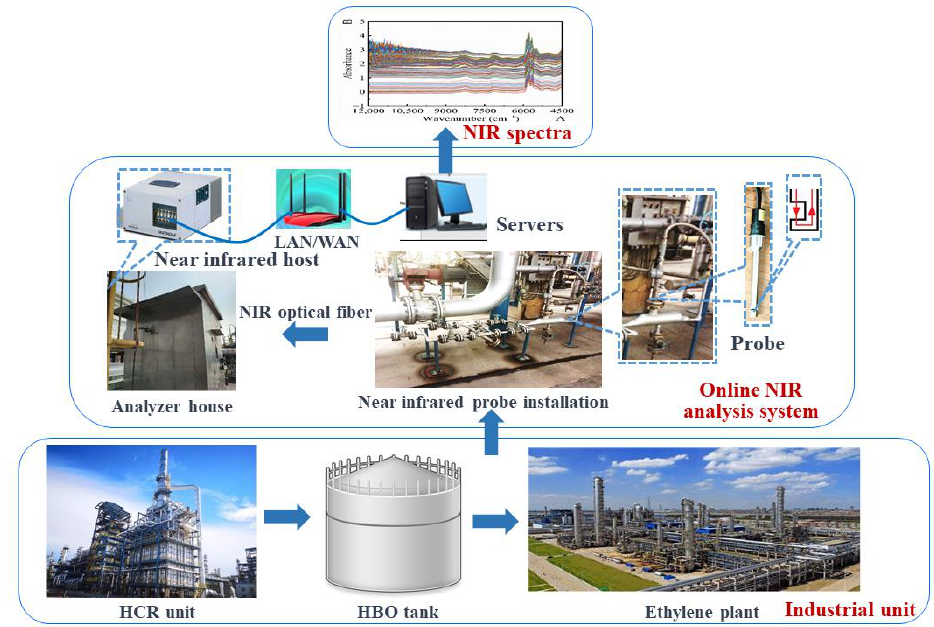
Figure 1. Sampling site and online method for measuring the NIR spectra of the HBO samples.